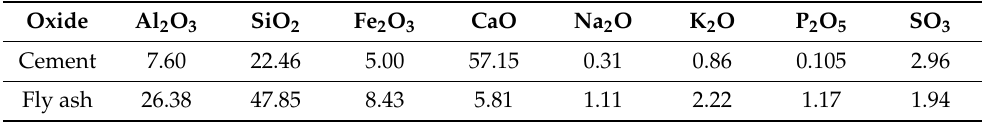
Table 1. Chemical properties of cement and fly ash (%).